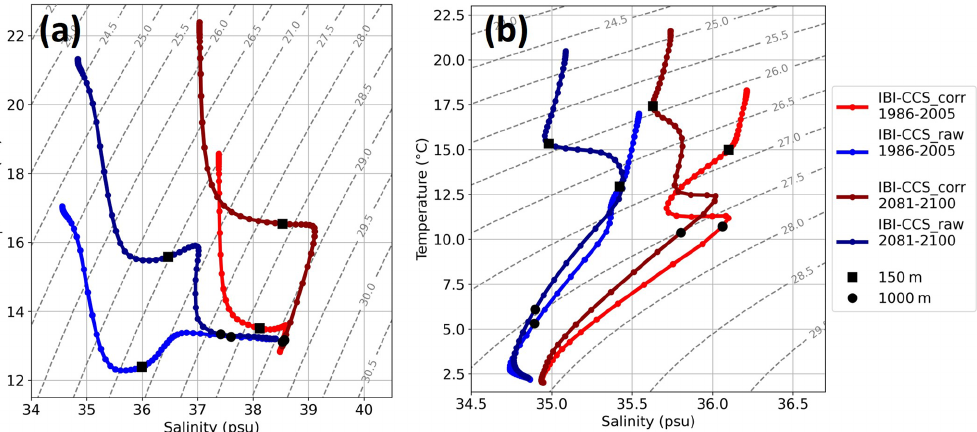
Figure 11. TS diagram for the SSP5-8.5 scenario for the present (1986–2005) (light line) and future (2081–2100) (dark line) periods for IBI-CCS_corr (red) and IBI-CCS_raw (blue) (a) in the western Mediterranean Sea and (b) at the starred location of Fig.